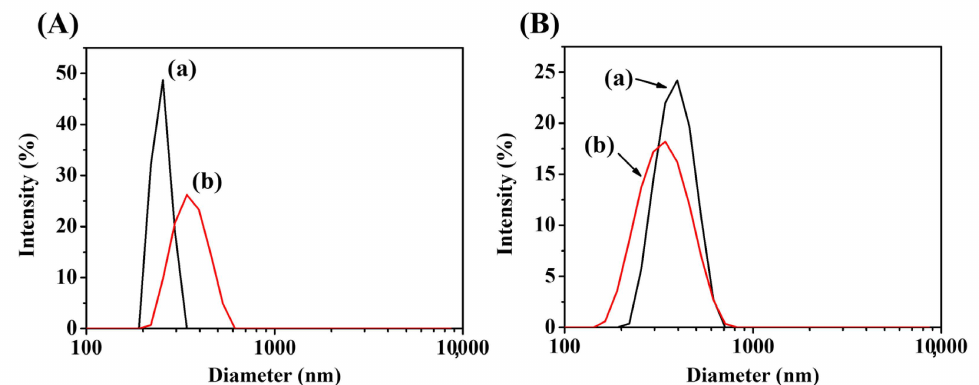
Figure 9. DLS curves of ( A ), (a) MCM-41 and (b) MCM-41-PAA; ( B ), Ca@MCM-41-PAA_5-FU with different pH environment of (a) pH 5.4 and (b)